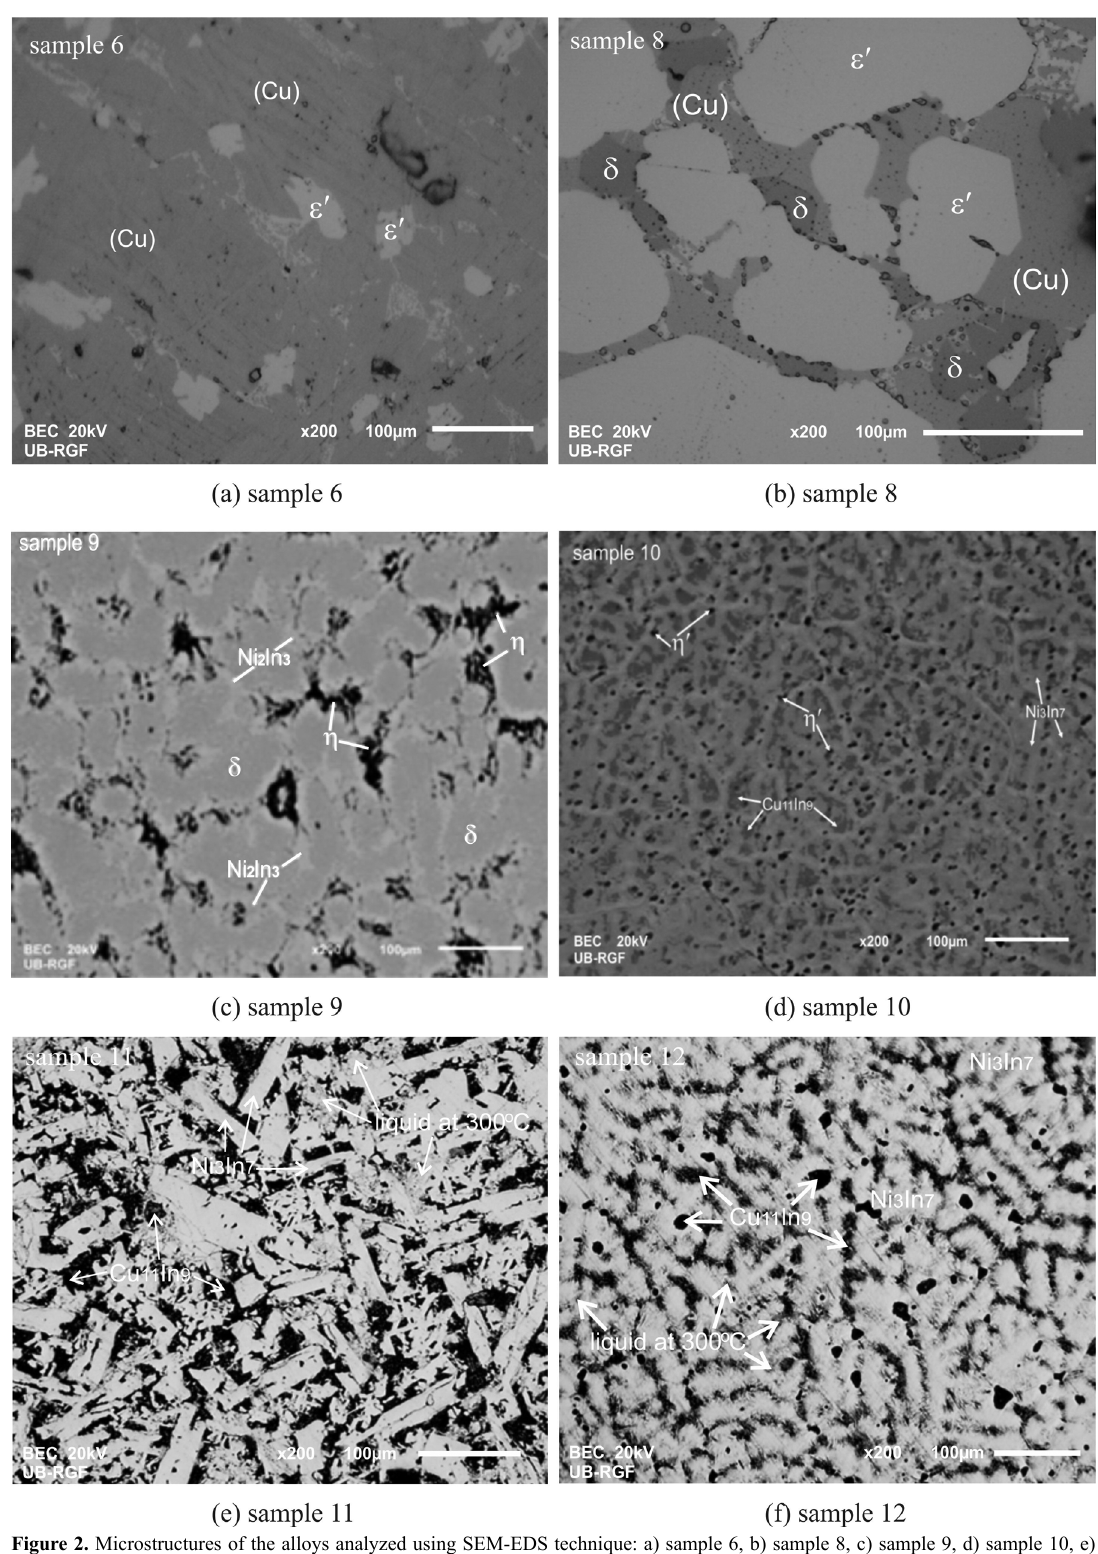
Figure 2. Microstructures of the alloys analyzed using SEM-EDS technique: a) sample 6, b) sample 8, c) sample 9, d) sample 10, e) sample 11 and f) sample